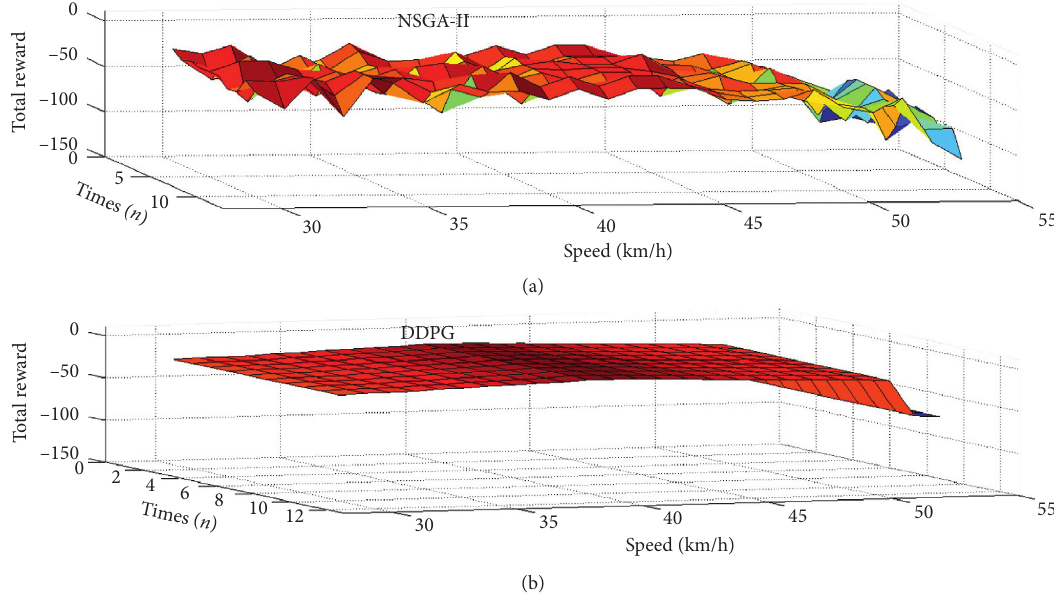
Figure 11: Stability and robustness of two